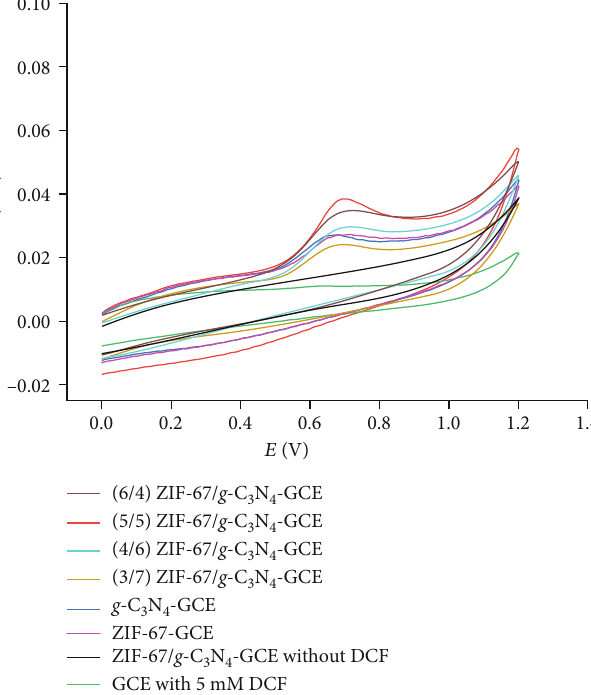
Figure 8: Cyclic voltammograms of 5 mM DCF in 0.2M BRB pH6 on GCE, ZIF-67-GCE, g -C